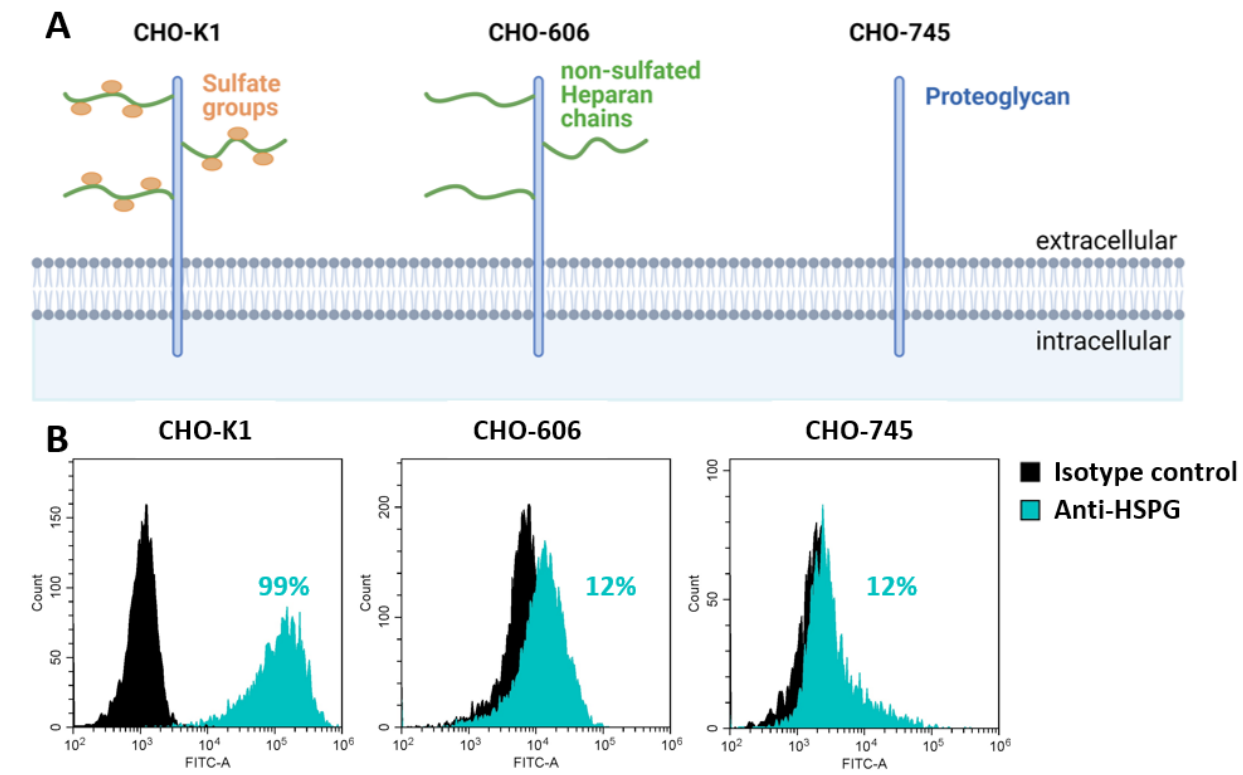
Figure 2. Different HSPG-expressions of CHO cell lines detected by flow cytometry. ( A ). The CHO-K1 cell line expresses the wild type form of HSPG with sulfated heparan chains on proteoglycan. CHO-606 cells have non-sulfated heparan chains and the CHO-745 cell line only the proteoglycan [10]. ( B ). The HSPG was detected by mouse anti-human heparan sulfate IgM (10E4 epitope, clone 8.S.087) and goat anti-IgM to mouse with AlexaFluor®488 antibodies. Stated in cyan is the percentage of HSPG-positive cells inside the whole cell population. Shown are the results of two independent experiments. Further details of the determination of the FACS results are mentioned in the supplementary material Method M1. Table 2. Summary of the results from the adenovirus screening in HSPG-depleted CHO cell lines. In green are Ad types with the highest uptake detected by luciferase assay in CHO-K1 cells, in blue are Ad types with the highest uptake in -606 and in orange are Ad types with the highest uptake in -745 cells are marked. Moreover, the known receptor and adapter usage is displayed for each Ad species adapted by Arnberg et al. 2012 [36], Hensen et al. 2020 [37] and Gao et al. 2020 [38]. Adenovirus Species Type Receptor Adapter B 3, 14 , 16 , 21 , 35 , 50 CAR, HSPG, VCAM-1 3 ,